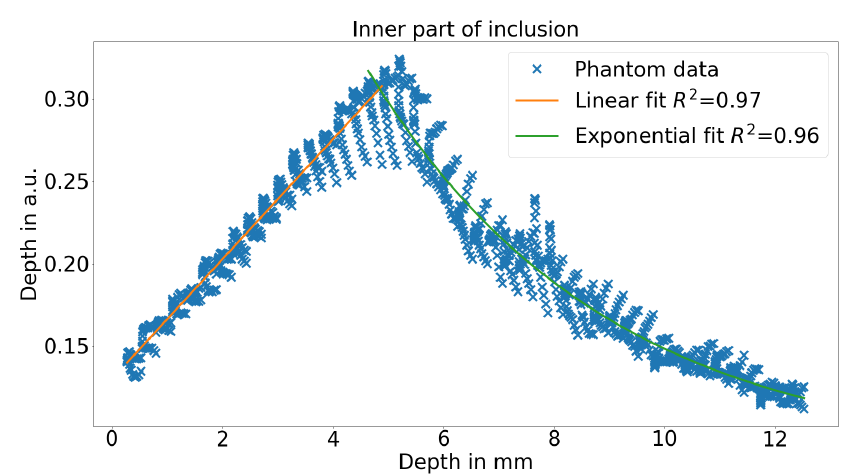
Figure 7. HSI depth parameter in the linear regime and the exponential regime over the real depth of the bottom channel with the according fits for the central part of the